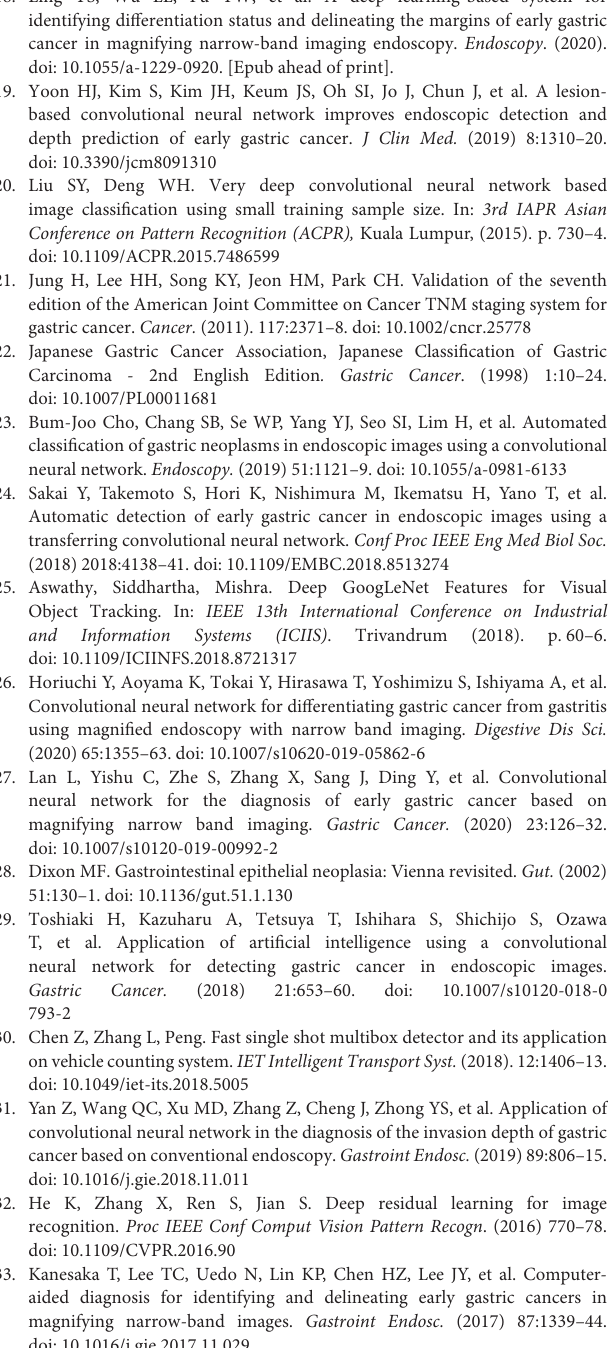
Supplementary Figure 2 | Quality of included studies according to QUADAS-2 scale. Supplementary Figure 3 | Influence analysis showed the significantly heterogeneity in Bum-Joo Cho, Hiroya Ueyama, and Yusuke Horiuchi’s study. Supplementary Figure 4 | Funnel plot showed no publication bias among the included